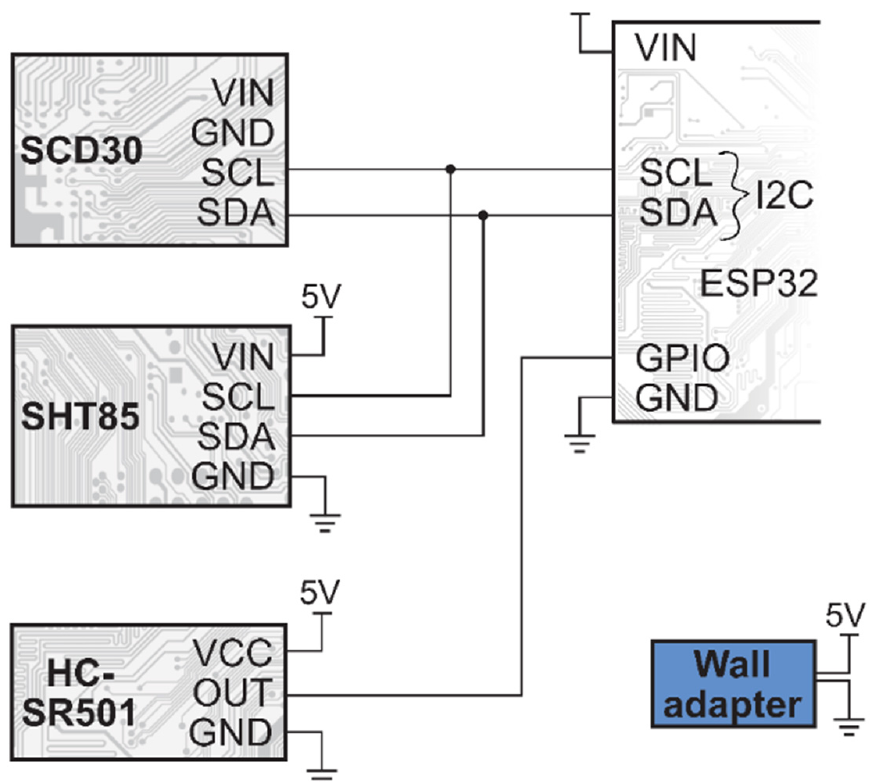
Figure 4. Room module schematic diagram.